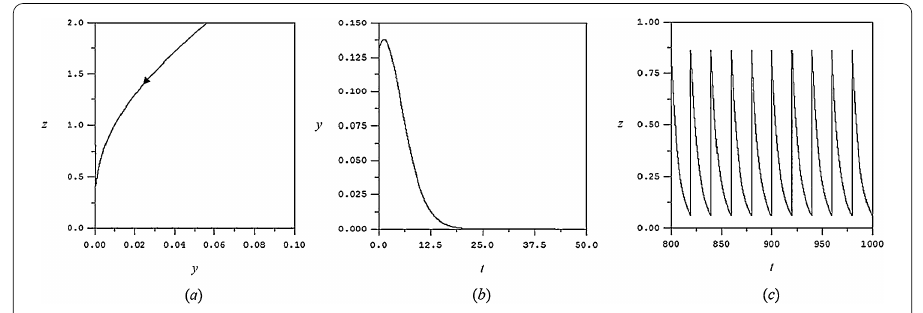
Figure 1 Numerical simulation of equations (3a)-(3d). The solution trajectory approaches oscillatory solution (0, ˜ z ( t )) as time passes. Here, all parameters are chosen to satisfy the conditions in Theorem 4.1, i.e., c 1 = 0.15, c 2 = 0.8, c 3 = 0.35, c 4 = 0.9, d 1 = 0.9, d 2 = 0.5, d 3 = 0.1, k 1 = 1.1, k 2 = 0.9, k 3 = 0.9, k 4 = 3.9, μ = 0.8, ρ = 0.5, T = 20, y (0) = 0.13, and z (0) = 5. (a) The solution trajectory projected on ( y , z )-plane. (b) The corresponding time course of the number of active osteoclasts ( y ) tending towards zero. (c) The corresponding time course of the number of active osteoblasts ( z ) exhibiting positive oscillation.